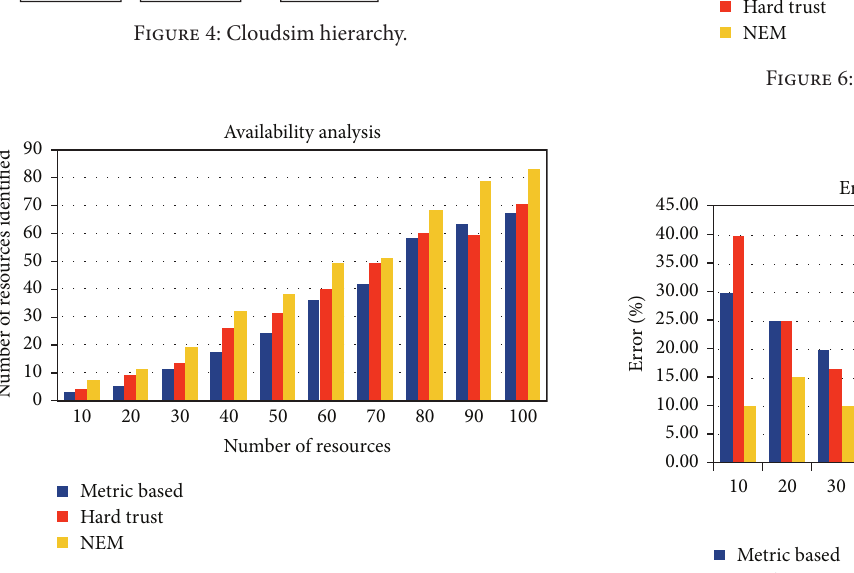
Figure 5: Trusted resources identified.